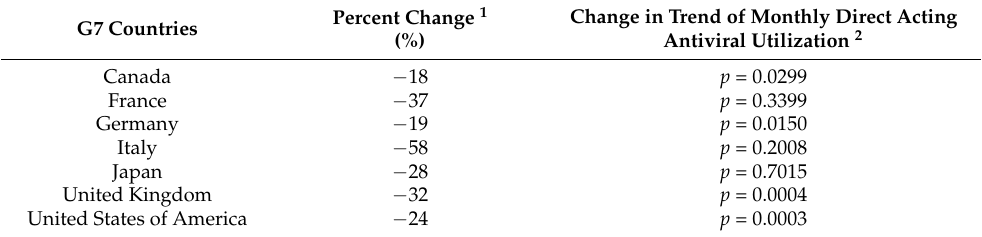
Figure 2. Direct Acting Antiviral units sold per 100,000 people from September 2018–August 2020 across the G7 countries. Dashed lined: declaration of the COVID-19 pandemic (March 2020). Table 1. Results of interrupted time-series model examining the impact of the COVID-19 pandemic on Direct Acting. Antiviral utilization across the G7